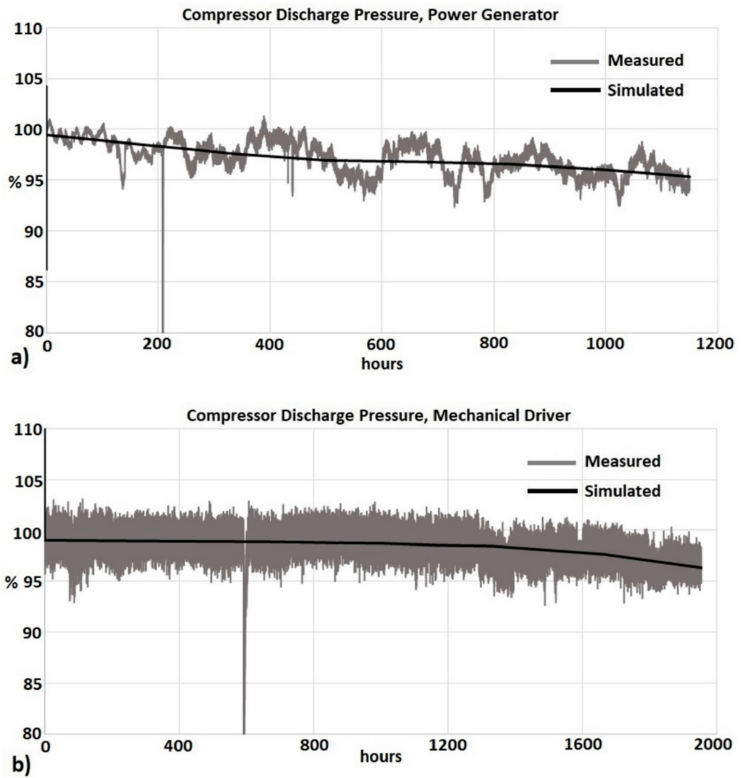
Figure 6. Measured and simulated compressor discharge pressures: ( a ) power generator; ( b ) mechanical